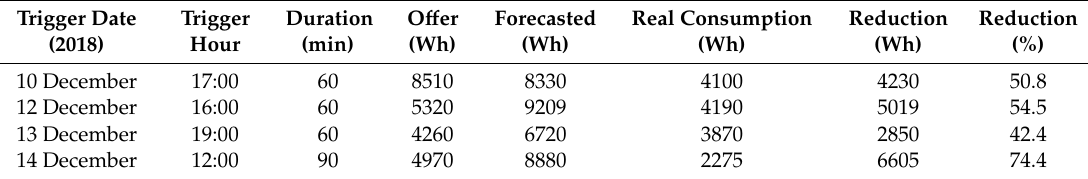
Table 1. Results of the real test performed with the proposed platform. Four days were